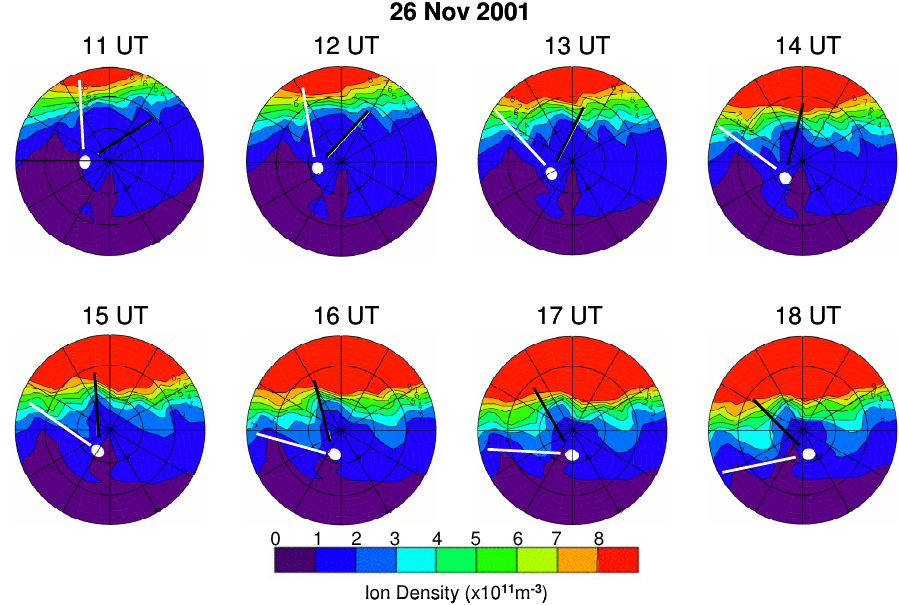
Fig. 12. Ion densities modelled by CTIP between 11:00UT and 18:00UT for 26 November 2001. The panels are at hourly intervals of UT, with each panel showing the ion density distribution at an altitude of 270km, near the F-region ionisation peak, as a function of MLAT and MLT. The format of the panels is as for Fig. 4, with the white line showing the 18 ◦ E meridian near the longitude of the Scandinavian tomography chain and the black line indicating the 54 ◦ W meridian near the longitude of the Greenland chain.